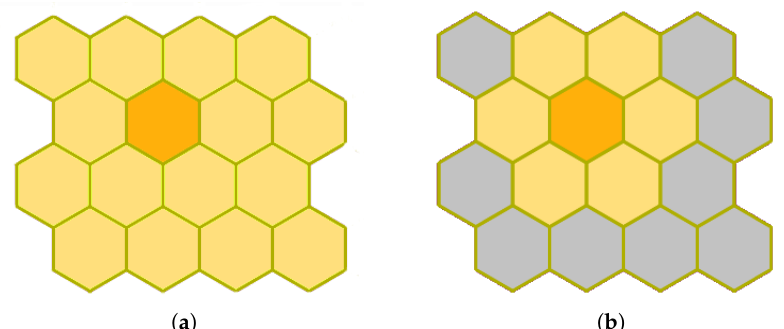
Figure 5. Differences in Self-Organized Map search spaces to determine a winner neuron for the current iteration. The search spaces are highlighted in yellow, whereas the winner neuron in the previous cycle is colored in orange. ( a ) regular SOM: the winner neuron is searched within the whole map; ( b ) fast SOM: The search space is restricted to the immediate neighborhood of the previous